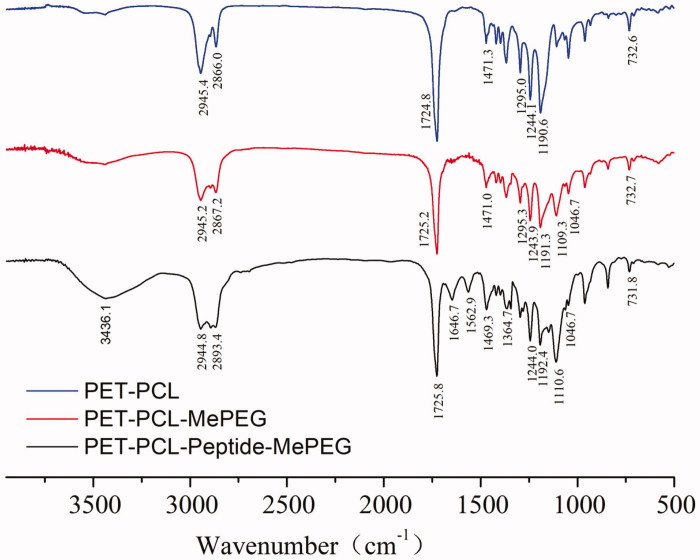
FT-IR spectra of PET-PCL, MePEG-PET-PCL, and MePEG-peptide-PET-PCL.